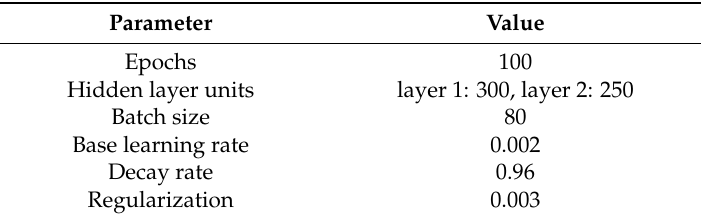
Table 4. Neural network model tuned